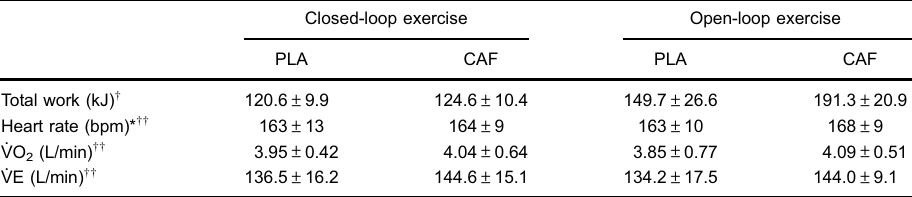
Figure 2. Reduction (means ± SD of percentage change from baseline to post-trial) in ( A ) maximal voluntary contraction (MVC), ( B ) evoked quadriceps twitch force (Q tw,pot ), and ( C ) voluntary activation (VA) after a 4,000-m cycling time trial (closed-loop exercise) and a task-to-failure trial (open-loop exercise) with caffeine and placebo ingestion. Trial vs time interaction, with a greater reduction from baseline to post-exercise in the open- than in the closed-loop exercise. Data are reported as means ± SD. *P o 0.05 (three-way repeated-measure ANOVA). Table 2. Total work and physiological responses during a 4,000-m cycling time trial (closed-loop exercise) and task-to-failure trial (open-loop exercise) with caffeine (CAF) and placebo (PLA) ingestion. Closed-loop